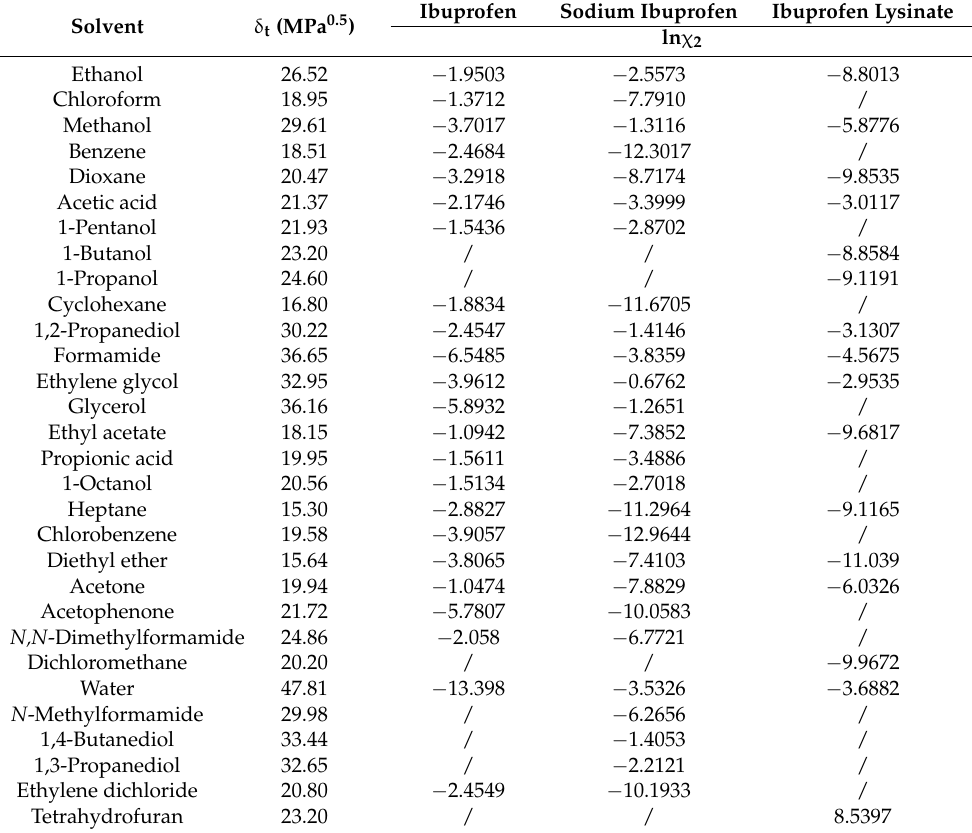
Figure 1. ln χ 2 as a function of total solubility parameter for ( a ) ibuprofen; ( b ) sodium ibuprofen and ( c ) ibuprofen lysinate. Table 3. Experimental determination of solubility, ln χ 2 , for ibuprofen and sodium ibuprofen (data taken from [35]) and ibuprofen lysinate. δ t (MPa 0.5 )